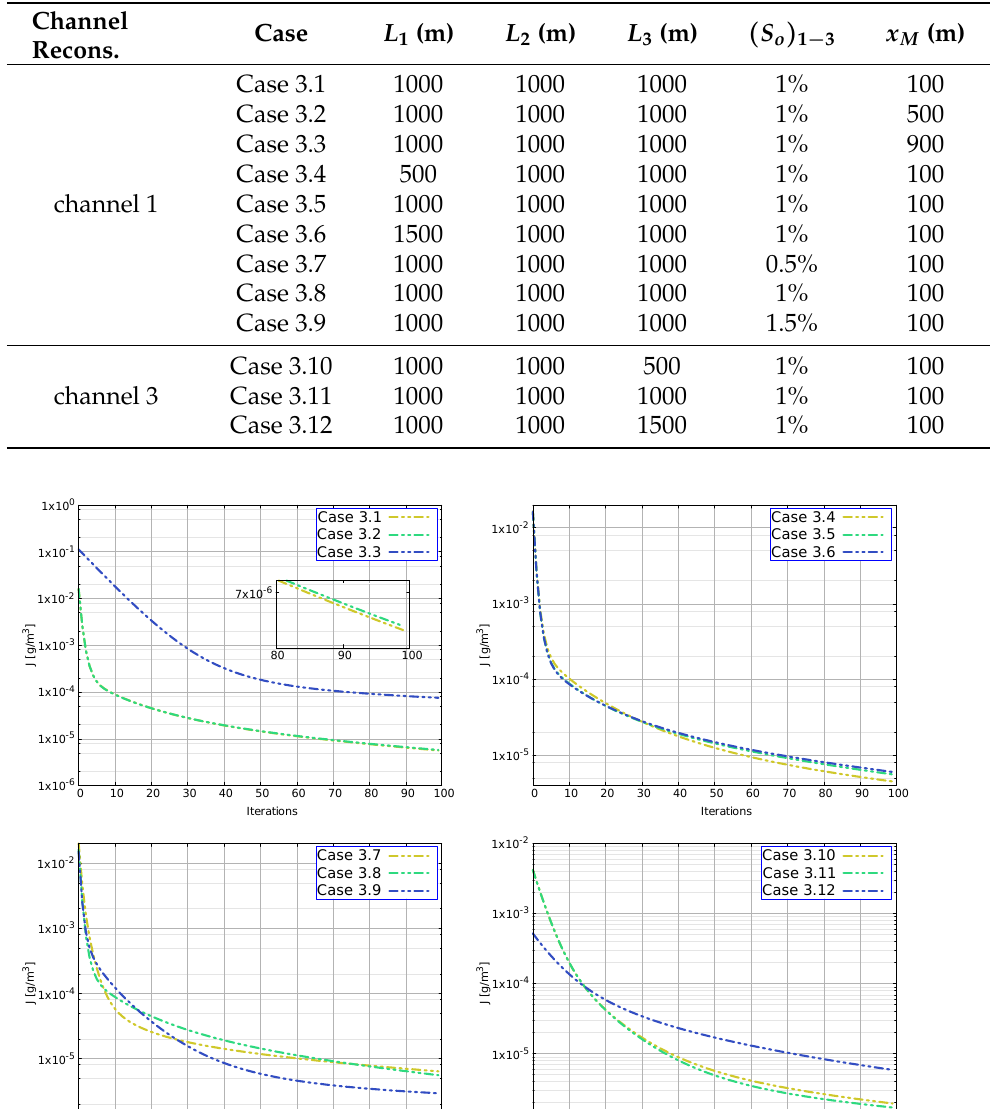
Table 2. Case 4. Location of the target measuring station (channel 2) and geometric properties.